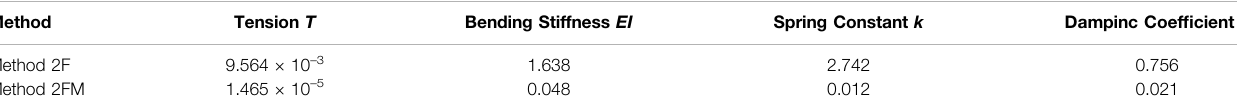
TABLE 5 | RMSER of estimation results for viscous shear damper in numerical veri fi